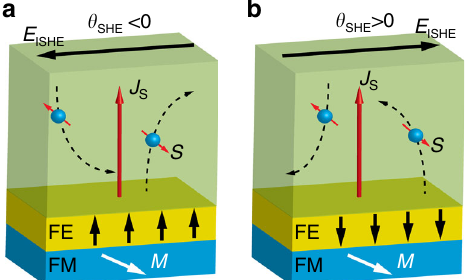
Fig. 1 Ferroelectric control of spin Hall angle. The spin-polarized electrons from the FM electrode tunneled into the metal are de fl ected sideways due to the ISHE. M , J S , S , E ISHE , and θ SHE denote the magnetization of the FM electrode, the tunneled spin-polarized current, the spin-polarization vector, the generated electric fi eld, and the spin Hall angle, respectively. The built- in electric fi eld from the FE surface dramatically in fl uences the electronic structure of the Pt layer at the interface and reverses the sign of the spin Hall angle, from which the detected ISHE voltage can be reversed based on the polarization state of PZT fi lm: a the up and b the down polarization states, as the arrows shown in the fi